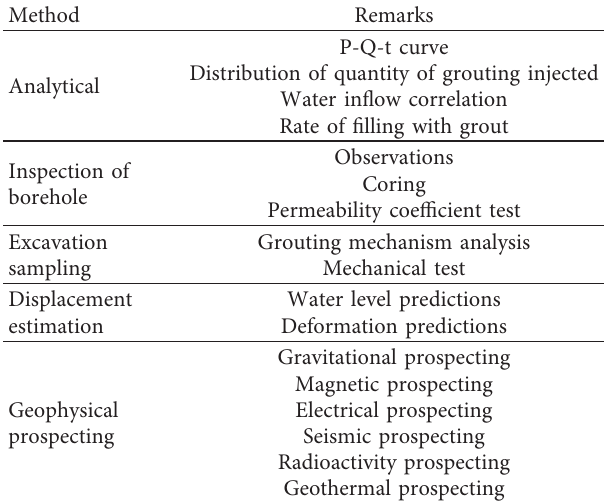
Table 1: Classification of evaluation methods of grouting